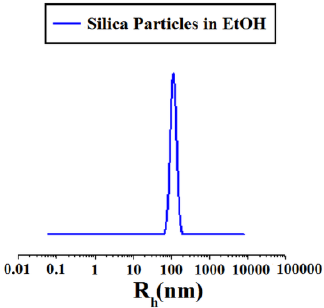
Figure 4. DLS of Stöber particles.